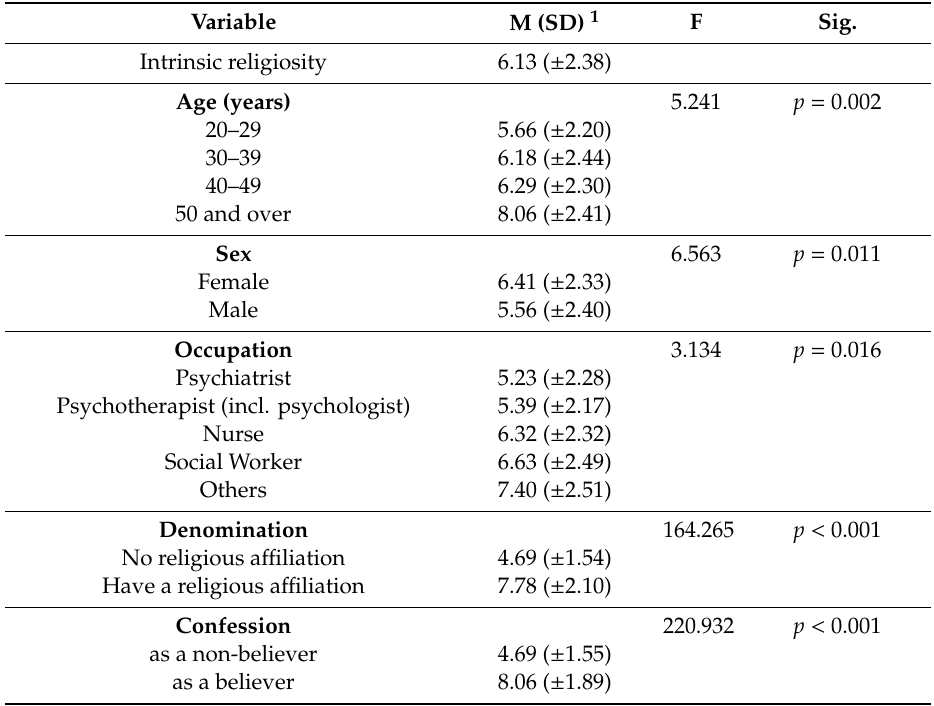
Table 3. Intrinsic religiosity between subgroups.